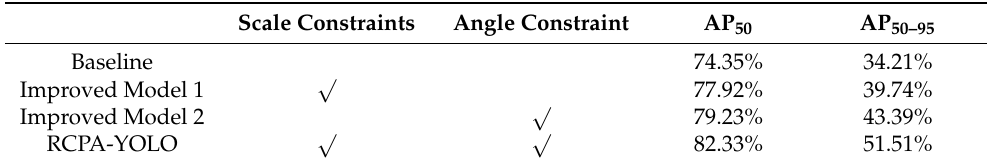
Table 2. Ablation test